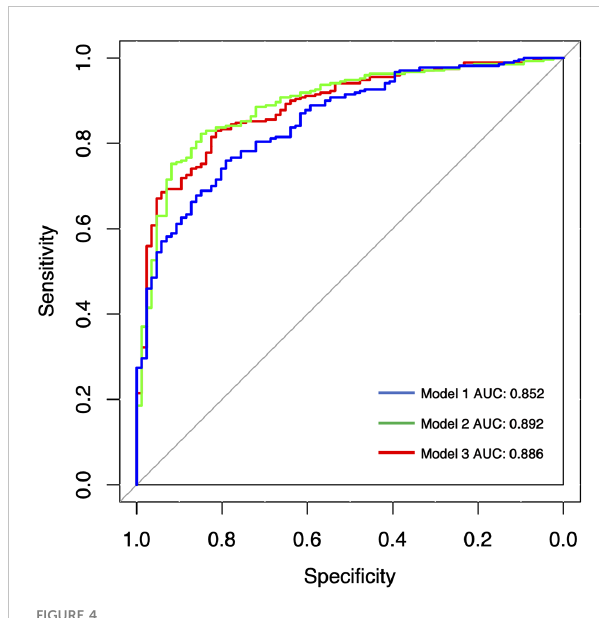
FIGURE 4 Receiver operating characteristic (ROC) analysis of assessing pathological invasiveness of PSN. AUC, area under the ROC curve; Model 1, clinical model; Model 2, histogram model; Model 3, integrated